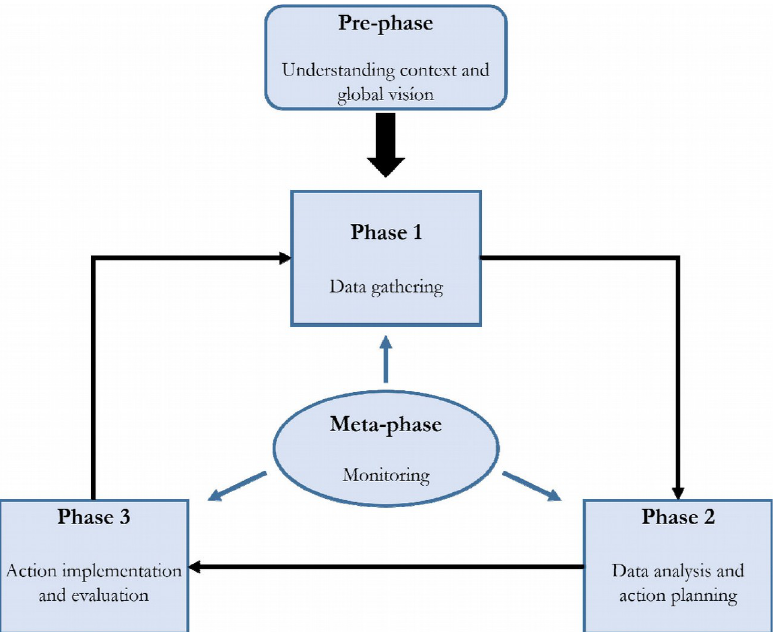
Figure 1. Action research cycle adapted from Coughlan and Coghlan (2002) and Fernández Vázquez-Noguerol et al.